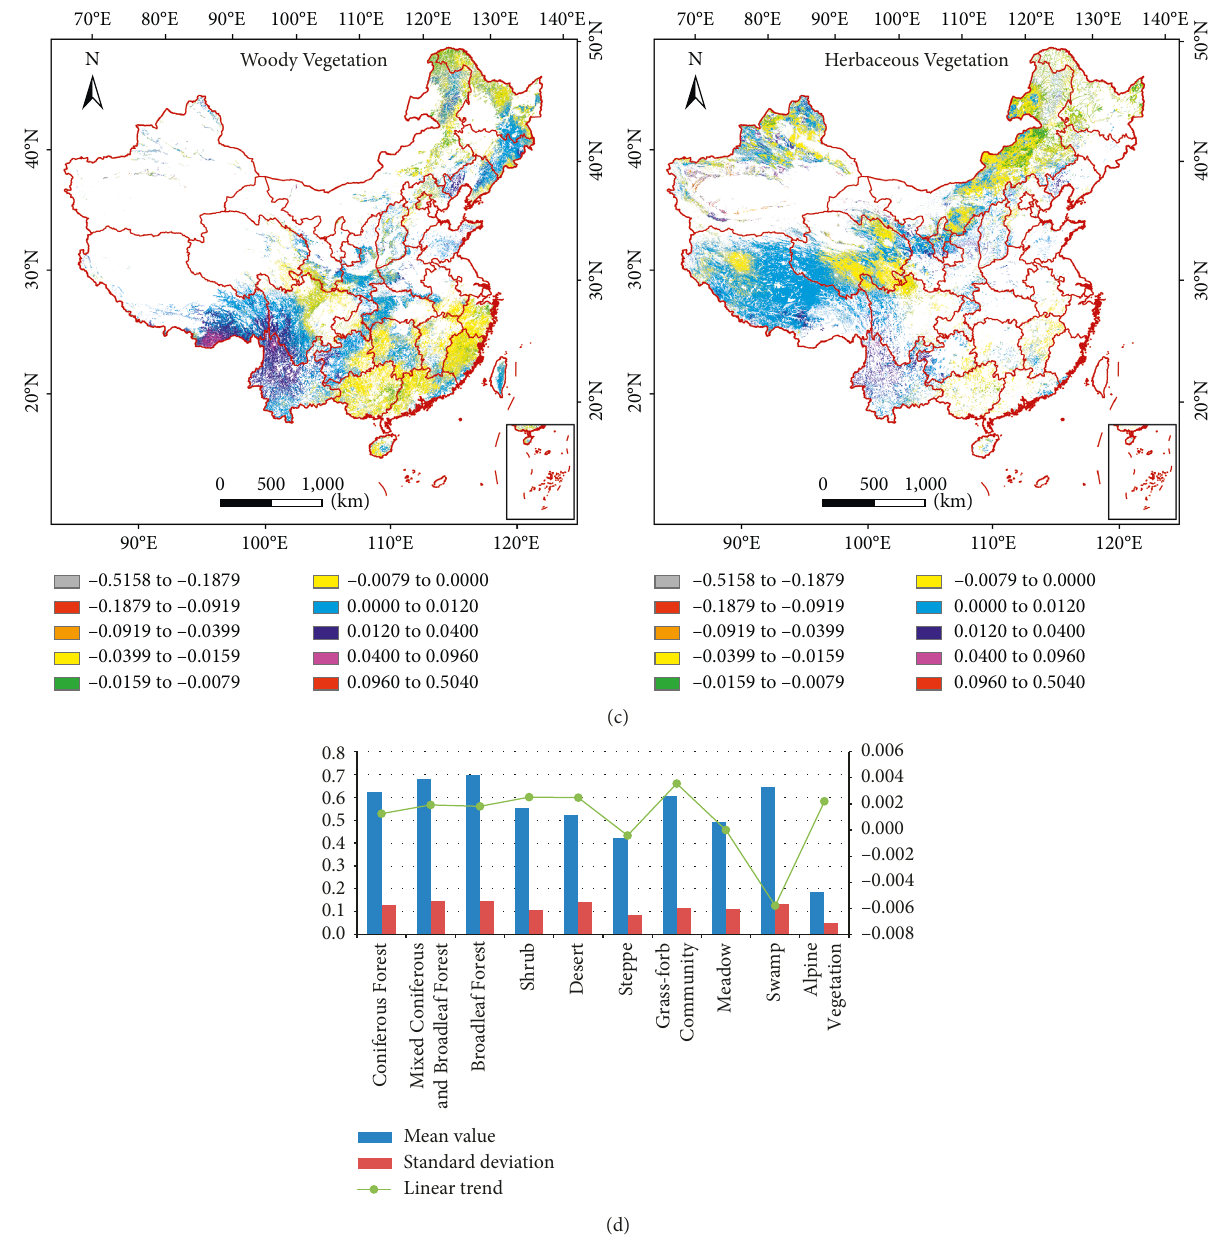
Figure 5: Temporal variation and spatial distribution of different Natural Vegetation types’ PUEs. (a) Spatial distribution of the multiyear mean values of Woody Vegetative and Herbaceous Vegetative PUEs. (b) Standard deviations of Woody Vegetative and Herbaceous Vegetative PUEs. (c) Linear trends of Woody Vegetative and Herbaceous Vegetative PUEs. (d) Statistical central tendency of the mean values, standard deviations, and linear trends of different Natural Vegetation types’